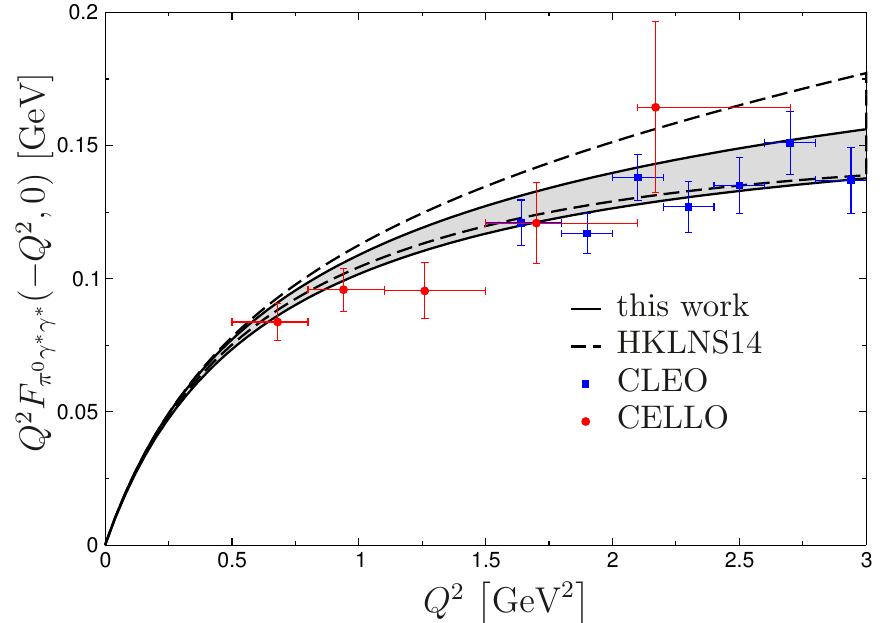
Figure 8. The singly-virtual form factors obtained in the current analysis (solid lines with gray uncertainty band) and from the once-subtracted representation [62] (HKLNS14, dashed lines) in the low-energy region, in comparison to CELLO [163] and CLEO [164]